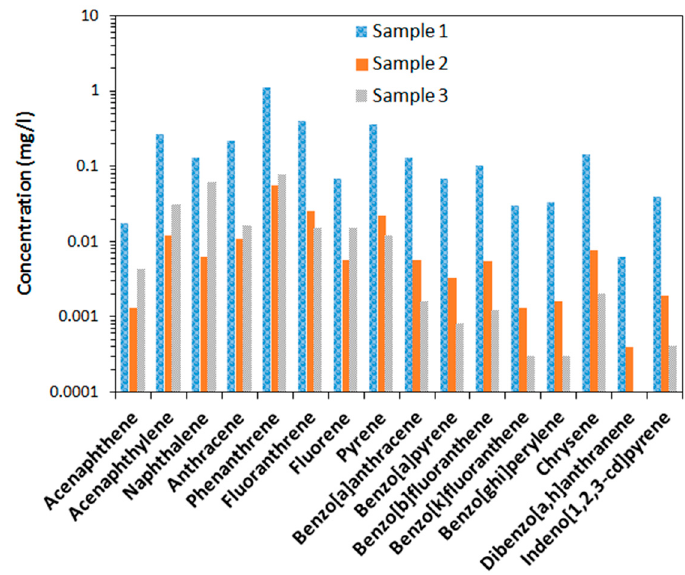
Figure 1. Concentration of PAHs in the collected fire extinguishing water samples from three different locations.